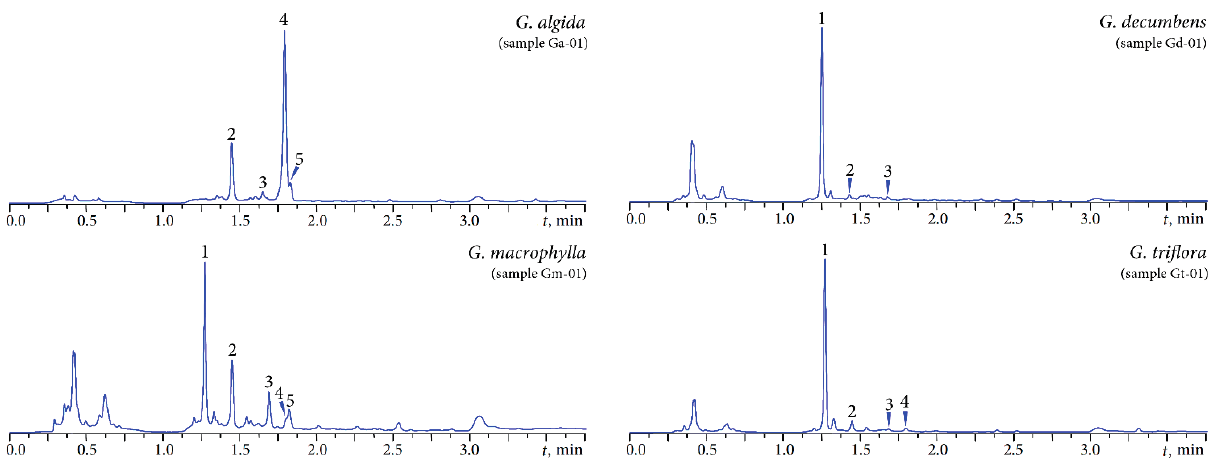
Figure 3. MC-RP-HPLC-UV chromatograms of the iridoid fractions of four gentian herbs detected at 230 nm. Compounds: 1 —loganic acid-6 ′ - O - β - D -glucoside; 2 —loganic acid; 3 —swertiamarin; 4 —gentiopicroside; 5 —sweroside. Table 1. MC-RP-HPLC-UV-ESI-MS characterisation of the iridoids of four gentian herbs. Peak